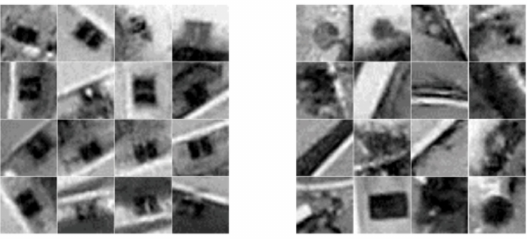
Figure 6. Examples of positive ( left ) and negative ( right ) training images used to train the Viola–Jones classifier. Despite the small resolution (32 × 32 pixels), sewer inlets are easily identifiable to the trained human eye—given adequate image